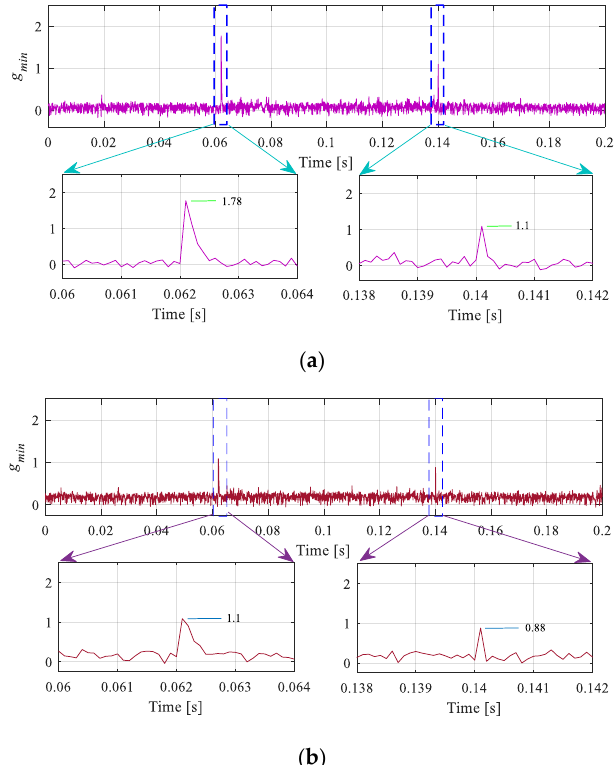
Figure 14. Experimental results: the values of minimum cost function g min for the FS-MPC in ( a ) αβ -frame and ( b ) dq -frame.